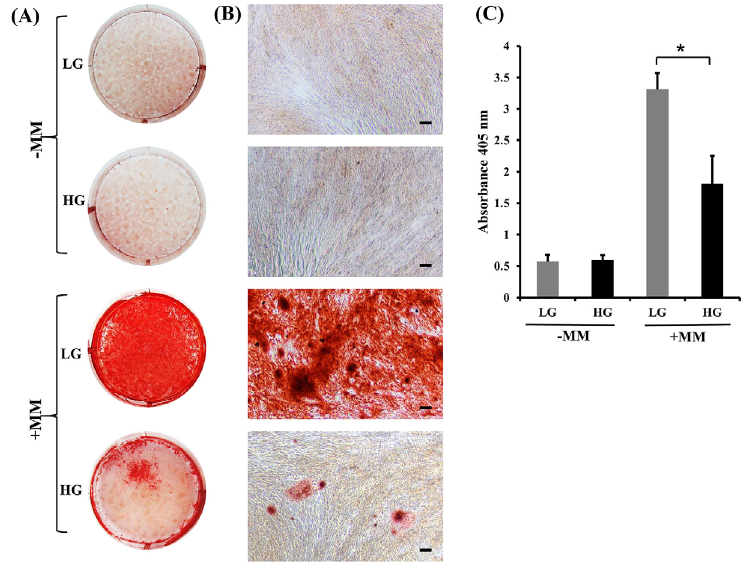
Figure 8- Mineralization of hDPCs. Staining of the alizarin red S–calcium complex; (A) overview, (B) original magnification 40× (scale bars = 100 μm) and (C) quantitation of mineral deposition. Mineralizing medium (MM), Low glucose (LG) and High glucose (HG). * indicates a statistically significant difference between groups